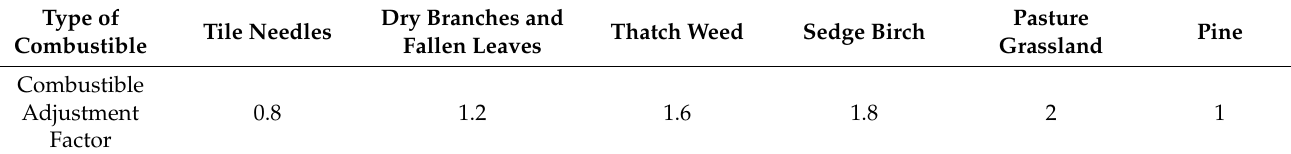
Table 2. Combustible Adjustment Factor